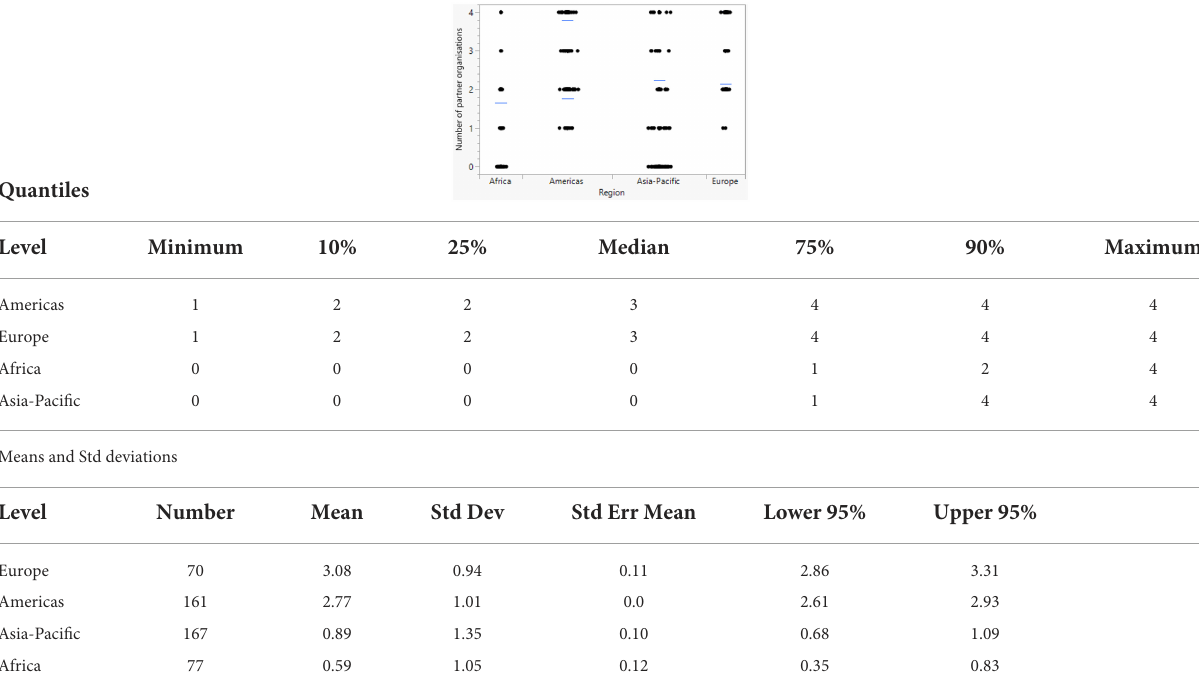
TABLE 3 Number of partner organizations by